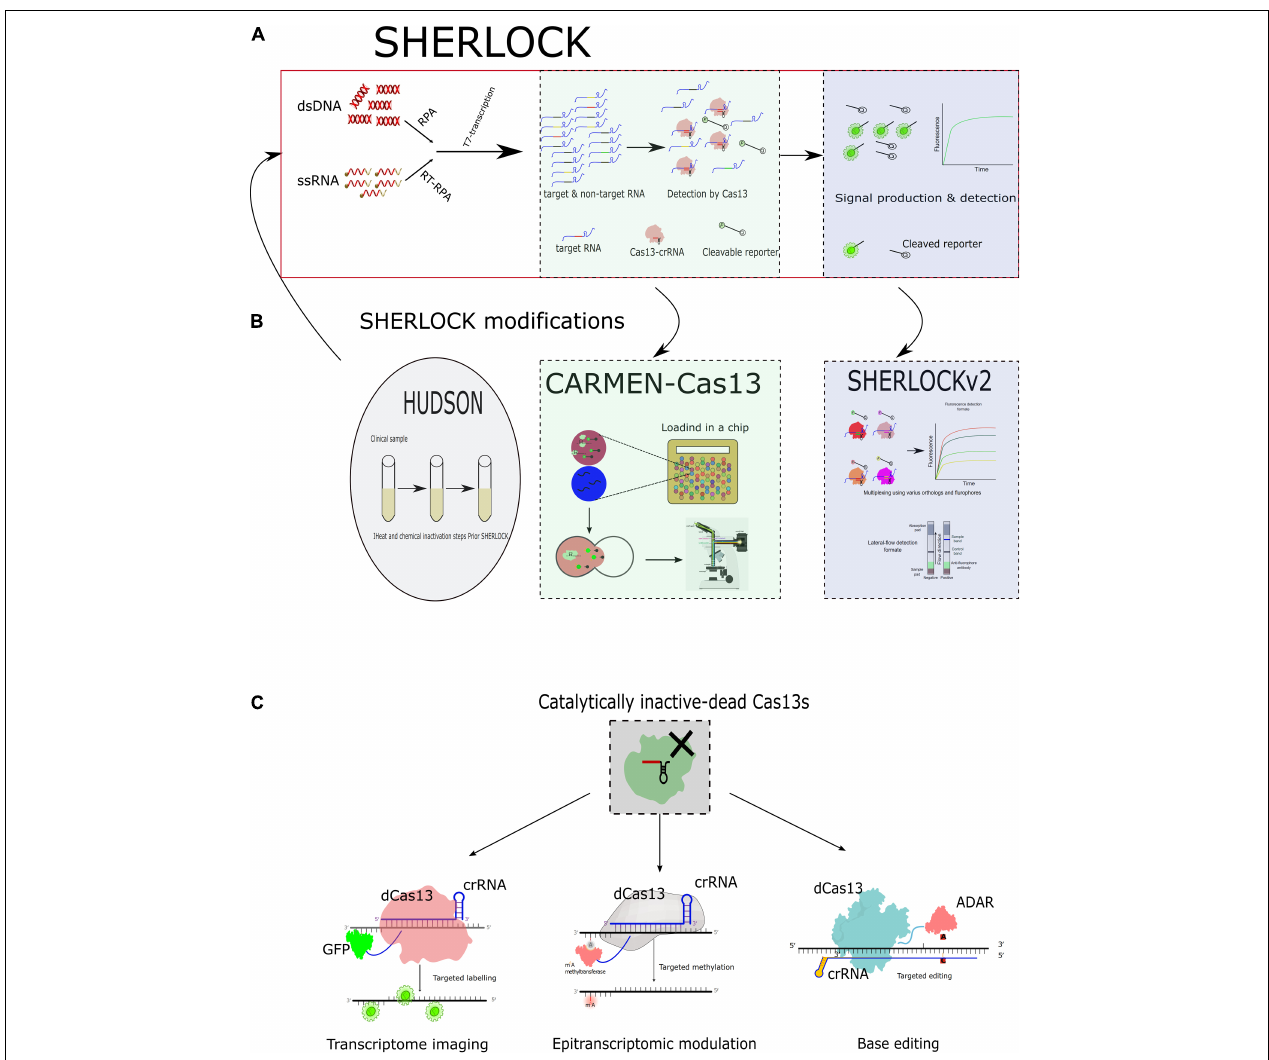
FIGURE 2 | CRISPR–Cas13-based diagnostics and applications of the catalytically inactive Cas13s (dCas13s) in virological applications. (A) Schematic diagram for Specific High-Sensitivity Enzymatic Reporter UnLOCKing (SHERLOCK). RPA, recombinase polymerase amplification. (B) Schematic diagrams for the modifications added to the SHERLOCK. HUDSON, heating unpurified diagnostic samples to obliterate nucleases; the HUDSON was usually performed before the prototype SHERLOCK. CARMEN, combinatorial arrayed reactions for multiplexed evaluation of nucleic acids; the emulsions were added to chip for detection, and the detection is usually occurs using fluorescence-based microscopy. SHERLOCKv2 differs from the prototype in using various Cas13 effectors represented by different color-coded proteins. SHERLOCKv2 varies in readout format as well as in lateral flow format. (C) Schematic representation of the possible applications of the catalytically inactive Cas13 (dCas13s) fusion for imaging, editing, and